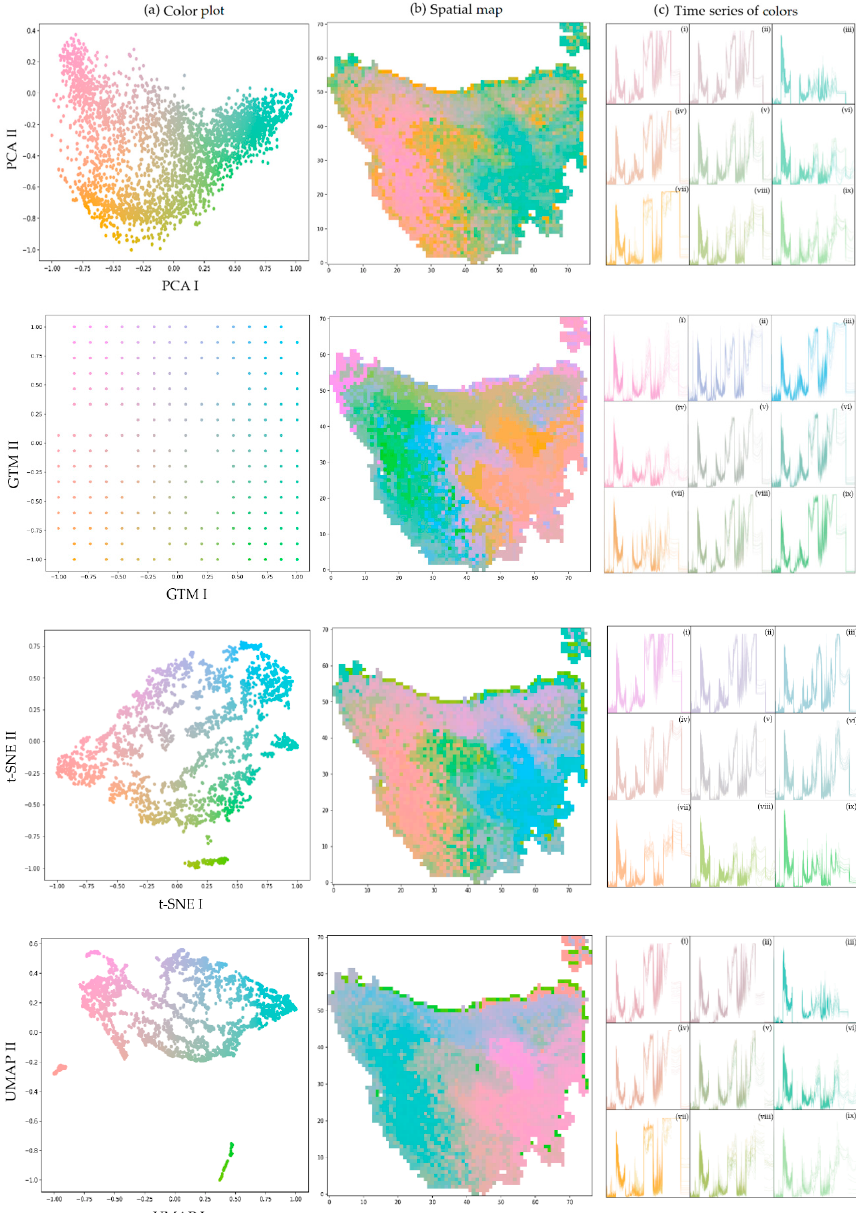
Figure 4. For principal component analysis (PCA), generative topographic mapping (GTM), t-distributed stochastic neighbor embedding (t-SNE) and uniform manifold approximation and projection (UMAP), ( a ) color plot shows a projection of high-dimensional data on 2D plane by preserving topology and maximize distances between projected and high-dimensional data for AWRA model output for Tasmania, 2017, ( b ) spatial map of Tasmania provides a quick spatial visualization of high-dimensional data features and ( c ) time series colored according to their position in 2D space. The subplots show 20 randomly selected time series from within 9 equally sized regions of the 2D